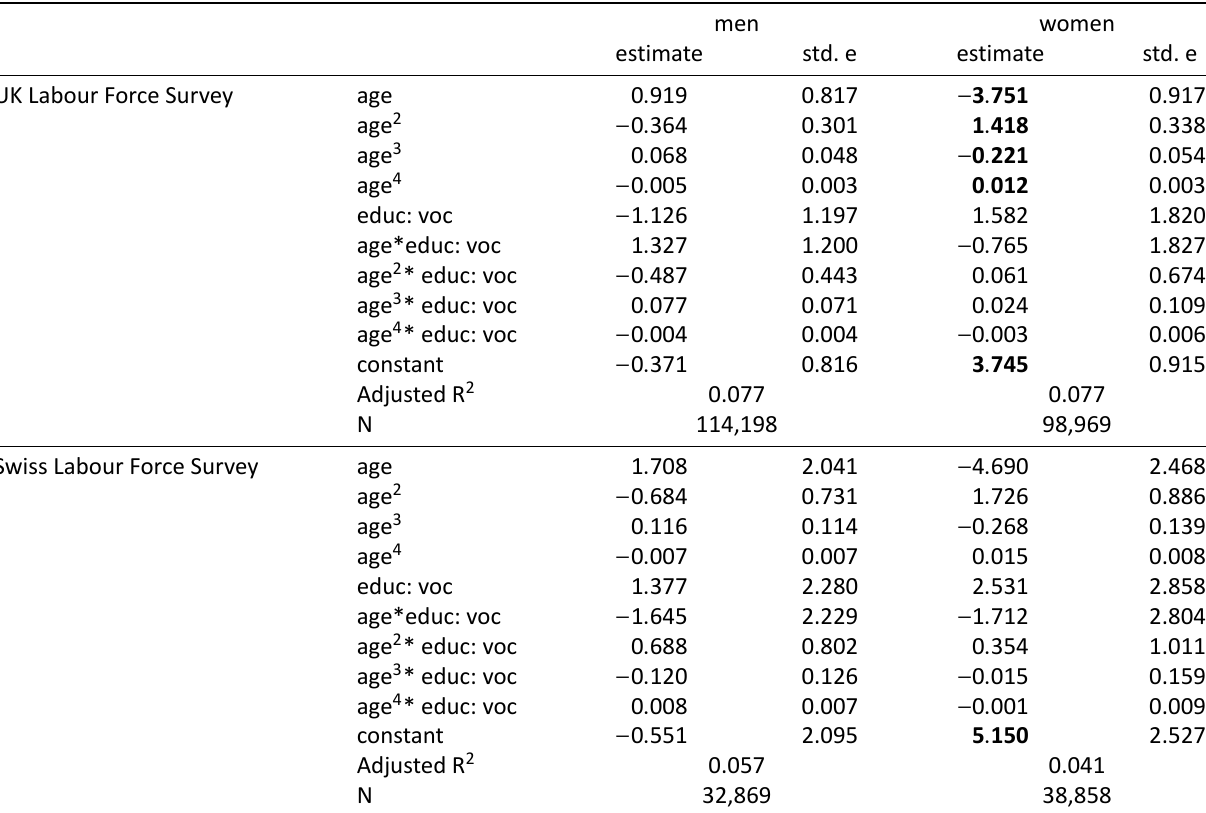
Table A2. OLS regression coefficients for being in employment (minimum 8 hours per week). Source: UK Labour